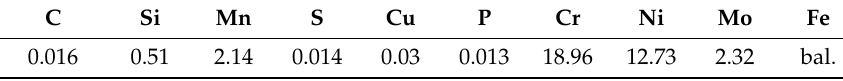
Table 1. Chemical composition of 316L wire (mass fraction %).